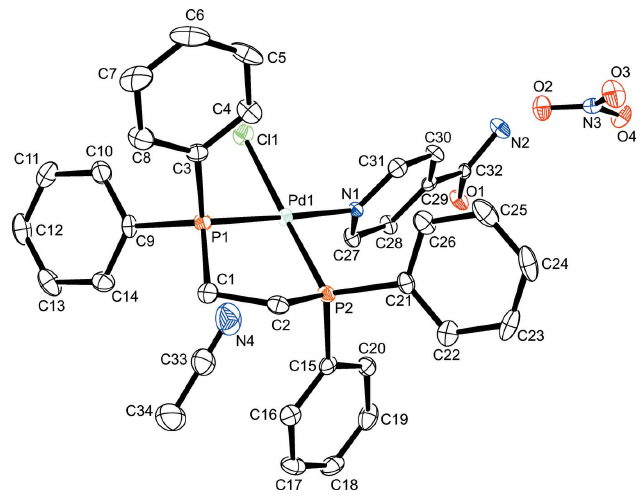
Figure 1 The structures of the molecular entities of the title compound with displacement ellipsoids drawn at the 50% probability level; H atoms are omitted for